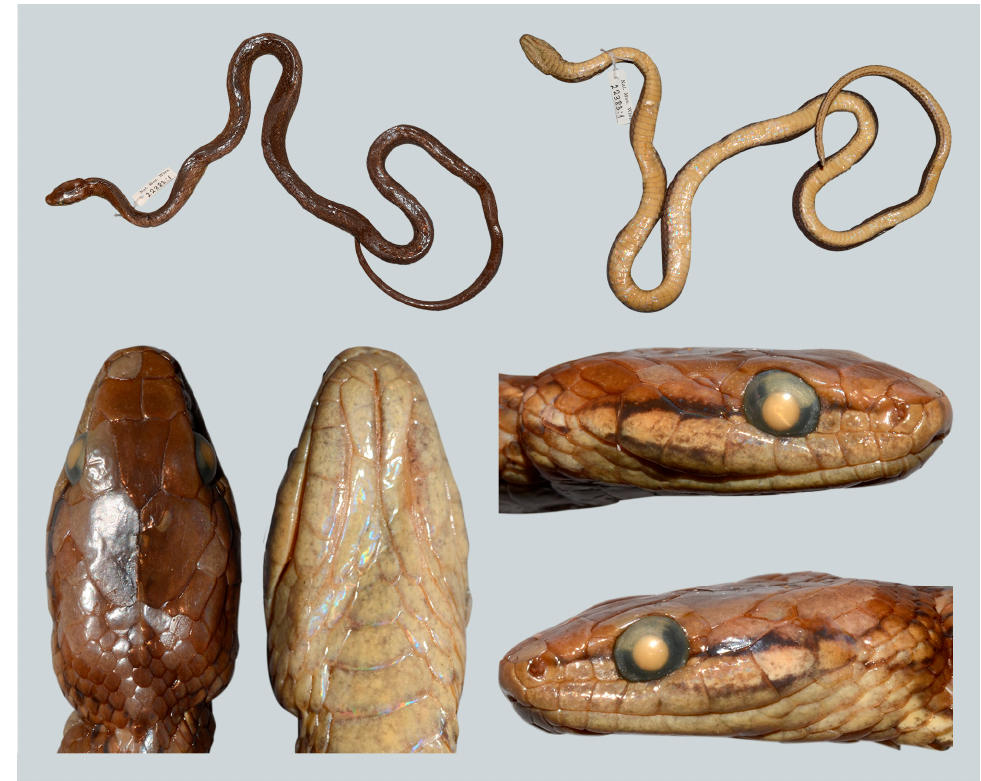
Figure 5. Preserved specimen of Herpetoreas sieboldii , NMW 22383: 1, adult male, Darjeeling, West Bengal, India. Not to scale. Photographs by Gernot Vogel.